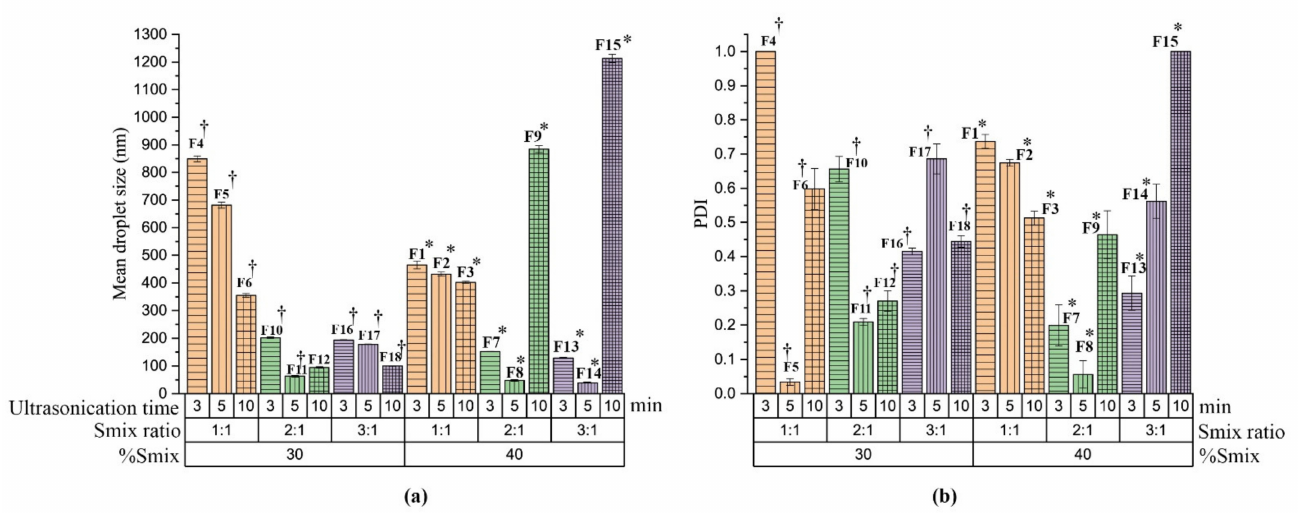
Figure 2. The influence of formulation composition of F1-F14 (Smix ratio, and %concentration of Smix) and the ultrasoni- cation process conditions (ultrasonication time) on the mean droplet size and PdI. ( a ) Mean droplet size of NE prepared by ultrasonication at an amplitude of 40% at a different time interval (3, 5, and 10 min) with different Smix ratios (1:1, 2:1, and 3:1) and Smix concentration at 30, and 40%. ( b ) PdI of NE prepared by ultrasonication at an amplitude of 40% at a different time interval (3, 5, and 10 min) with different Smix ratios (1:1, 2:1, and 3:1) and Smix concentration at 30, and 40%. † represents formulation compositions as %oil, %Smix, and %water are 10%, 30%, and 60% respectively while * represents formulation compositions as % oil, % Smix, and %water are 10%, 40%, and 50%,